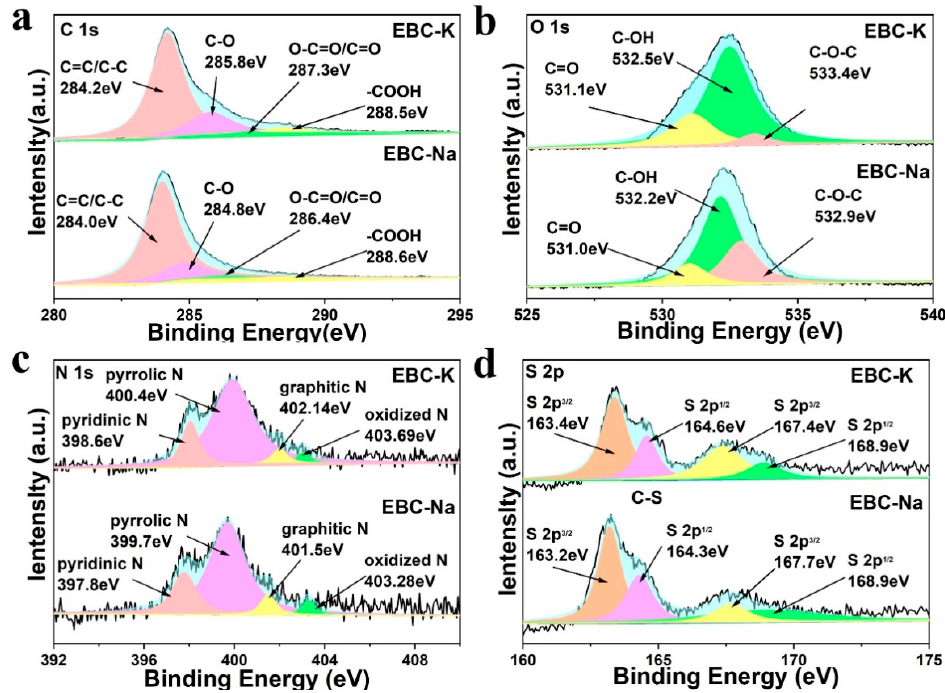
Figure 3. High resolution XPS spectrum of EBC ‐ Na and EBC ‐ K, ( a ) C 1s, ( b ) O 1s, ( c ) N 1s, and ( d ) S 2p. Table 1. the fitting results of the high resolution XPS spectra of C, O, N, and S for EBC ‐ K and EBC ‐